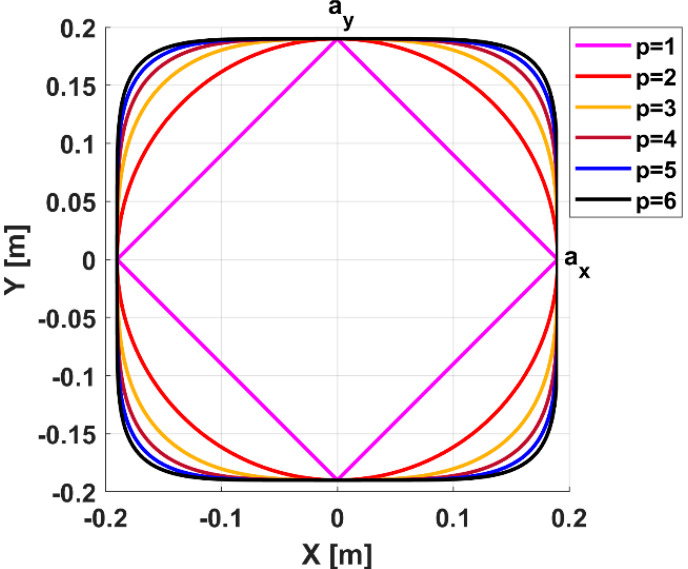
Figure 1. A turn shape with radii a x and a y in x and y directions, respectively. The shape of the turn is changing according to the value of the quasi-elliptic parameter ( p ). Both the transmitter and receiver coils were assumed to have a specific number of turns (𝑁 (cid:3047) = 19) , and the distance between the coils ( 𝐷) was set to 15 cm. The minimum distance between the consecutive turns in each coil was constrained to 7 mm. As demon- strated in Figure 2, the turns occupied the locations between the inner radius 𝑅 (cid:2868) and the outer radius 𝑅 (cid:2869) . The outer radius was fixed and set to 190 mm. A spiral connection was applied to connect the separated turns by gradually changing the radius of a single turn in Equations (1)–(4) from its current value to the next outer turn radius value.